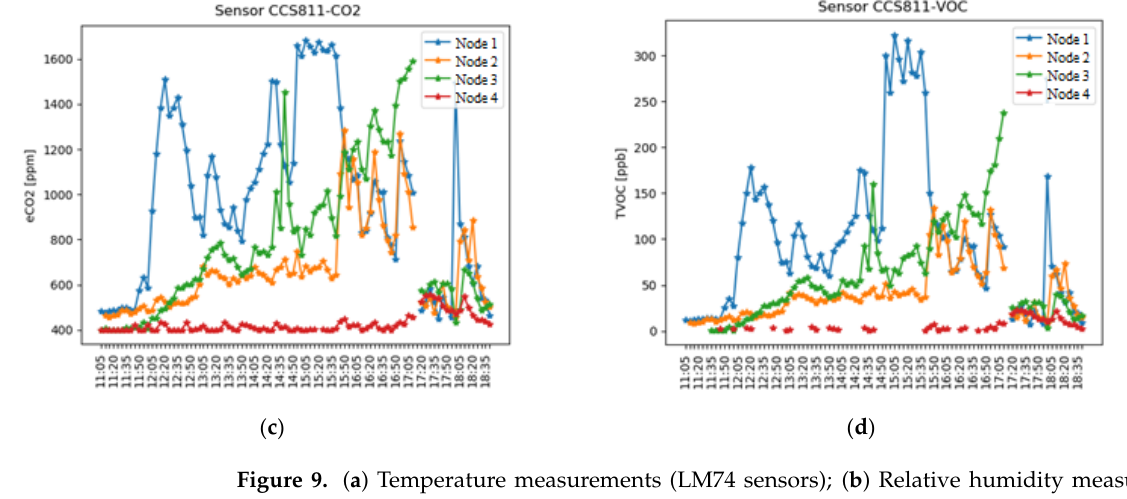
Figure 9. ( a ) Temperature measurements (LM74 sensors); ( b ) Relative humidity measurements (SHT85); ( c ) eCO 2 measurements (CCS811); ( d ) TVOC measurements (CCS811).